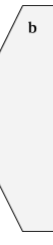
Figure 1. a within